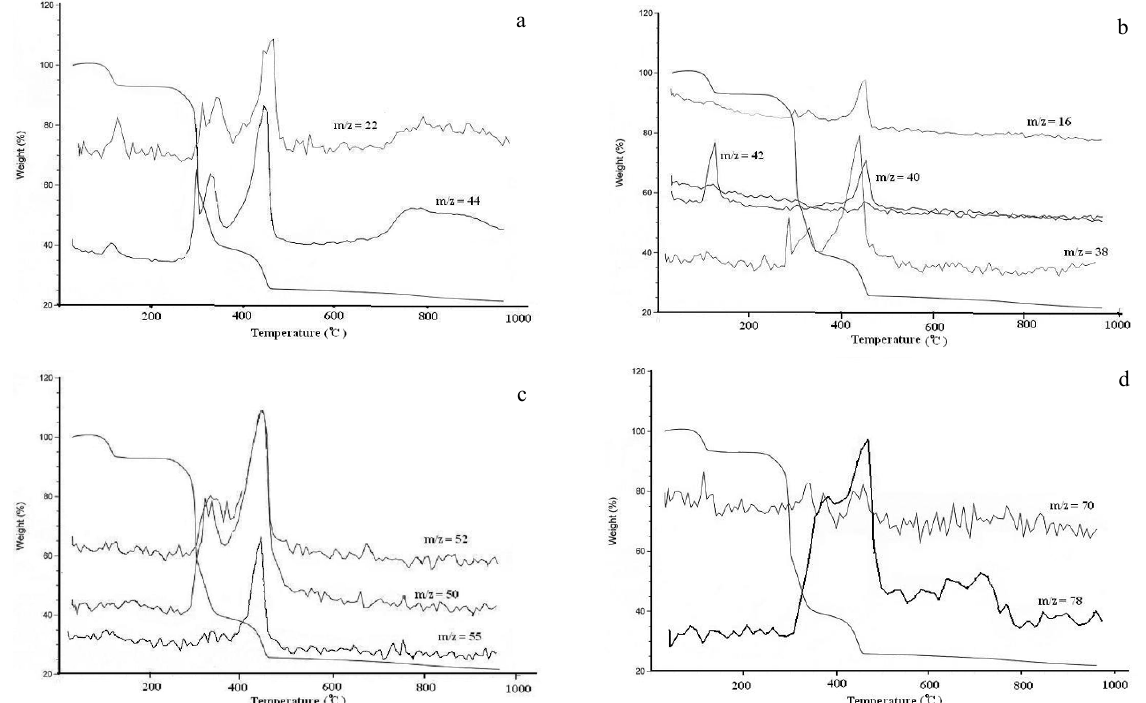
Figure 4. TG Curve of Cu